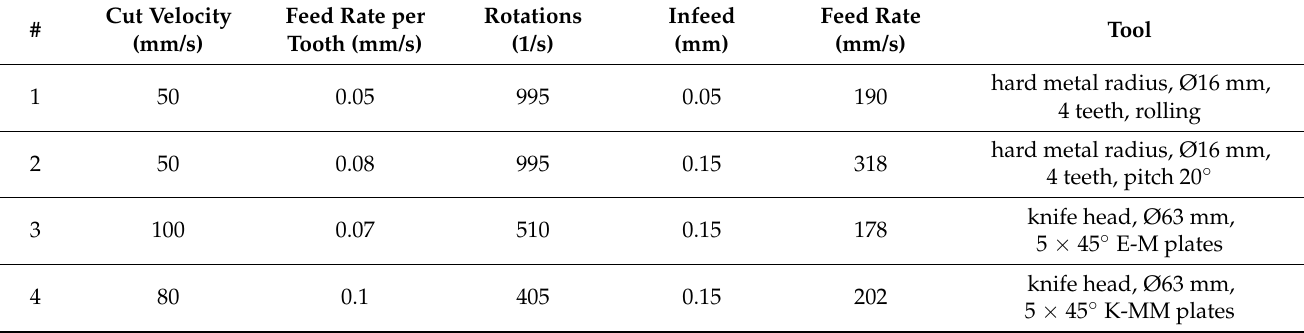
Table 4. Milling parameters for four surface machining procedures (# 1–4), performed by an industrial CNC facility.